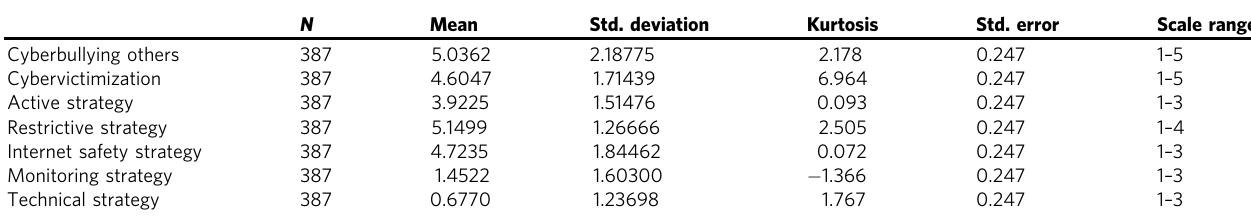
Table 3 Descriptive statistics for variables used investigating the impact of parental mediation strategies on adolescents ’ engagement in cyberbullying and cybervictimization.